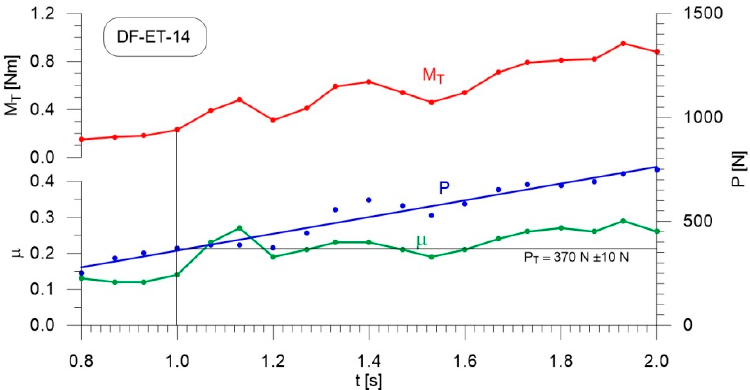
Figure 11. Courses of the load, P, the friction torque, M T , and the friction coefficient, µ , for diesel–